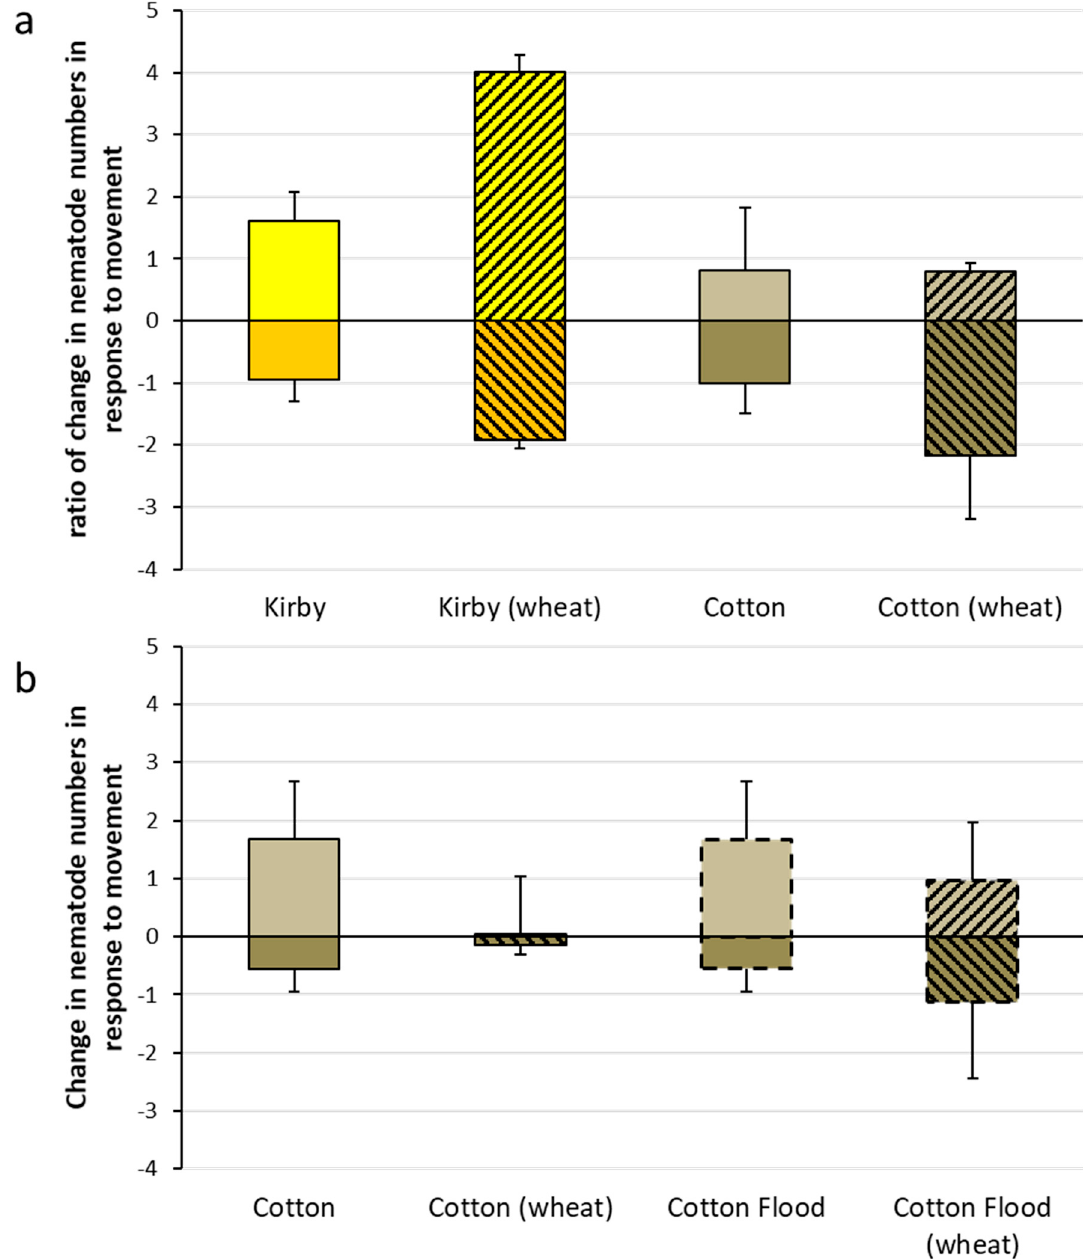
Figure 2. The ratio of nematodes recovered from sterilised soil situated either above or below non-sterile soil, compared to those recovered from a completely sterile treatment. A ratio of more than 1 (for upward movement, lighter shades) and − 1 (for downward movement, darker shades) indicates an increase over the control. Kirby (Yellow) and Cotton (Brown) indicate where soil was sourced with ( a ) looking at the impact of sowing wheat (diagonal black shading) on nematode recovery, while ( b ) is the analysis of the impact of a maintained versus flood irrigation treatment (black dashed border) only in the Cotton soils.